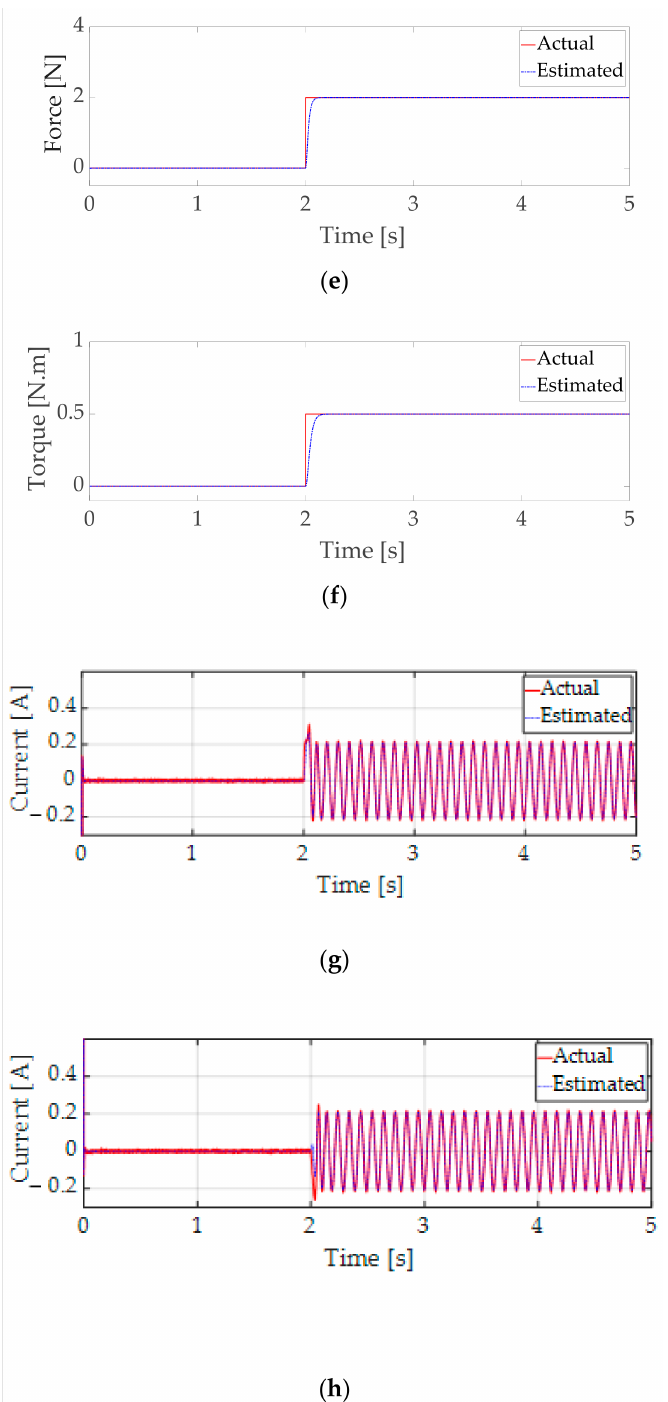
Figure 6. Estimation performance of the proposed ANOB. ( a ) Estimation performance of θ x and ˆ θ x . ( b ) Estimation performance of θ y and ˆ θ y . ( c ) Estimation performance of θ yaw and ˆ θ yaw . ( d ) Estimation performance of d x and ˆ d x . ( e ) Estimation performance of d y and ˆ d y . ( f ) Estimation performance of d yaw and ˆ d yaw . ( g ) Estimation performance of i x 1 a and ˆ i x 1 a . ( h ) Estimation performance of i x 1 b and ˆ i x 1 b